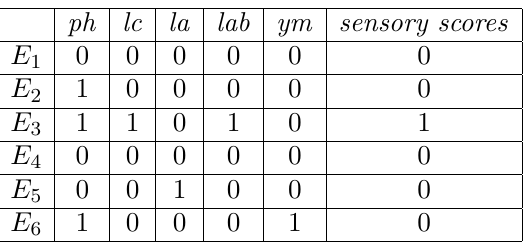
Table 3. The results for x = 30 and i = 1 to